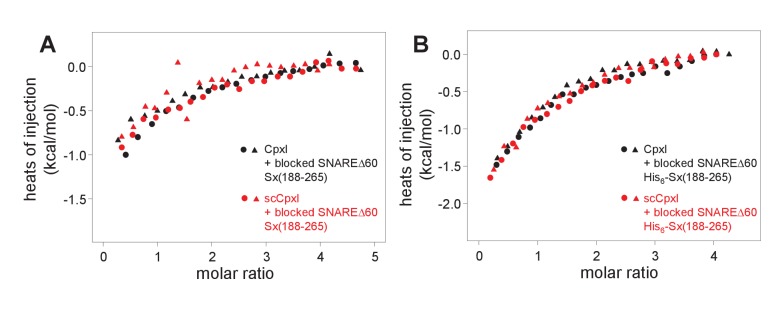
The superclamp mutation does not alter the heat release observed in the blocking assays.The plots show superpositions of ITC data obtained in blocking assays such as those described in Figure 3, including two separate experiments performed with WT CpxI and two separate experiments performed with scCpxI, titrated into blocked SNAREΔ60-Sx265 (A) or His6-SNAREΔ60-Sx265 (B) complexes. To facilitate comparison of the four data sets shown in each panel, a constant value resulting from the average of the last five data points was subtracted from each data point of a given dataset. Note that, as a consequence, the baseline at the end of the titration is closer to zero than observed in the plots of Figure 3G,H,L,M, where the baseline was determined by the data fitting procedure. The data superpositions show that the superclamp mutation does not markedly influence the heat release observed in experiments performed with blocked SNAREΔ60-Sx265 (A) or His6-SNAREΔ60-Sx265 (B) complexes.